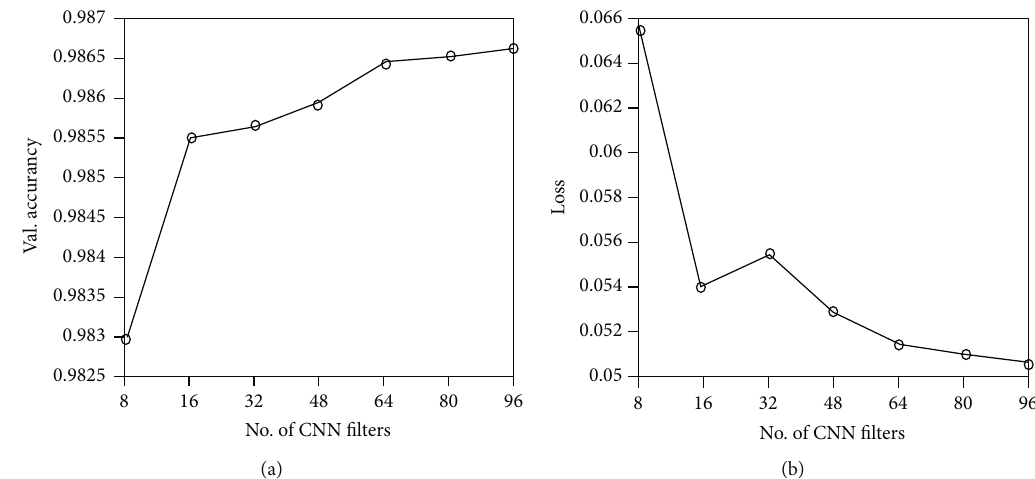
Figure 5: Val. accuracy and training loss of di ff erent Nos. of CNN fi lters: (a) fi nal ( epoch = 2000 ) accuracy on validation set; (b) loss at the end of training ( epoch = 2000 ). Each data point is an average value of 30 trainings.